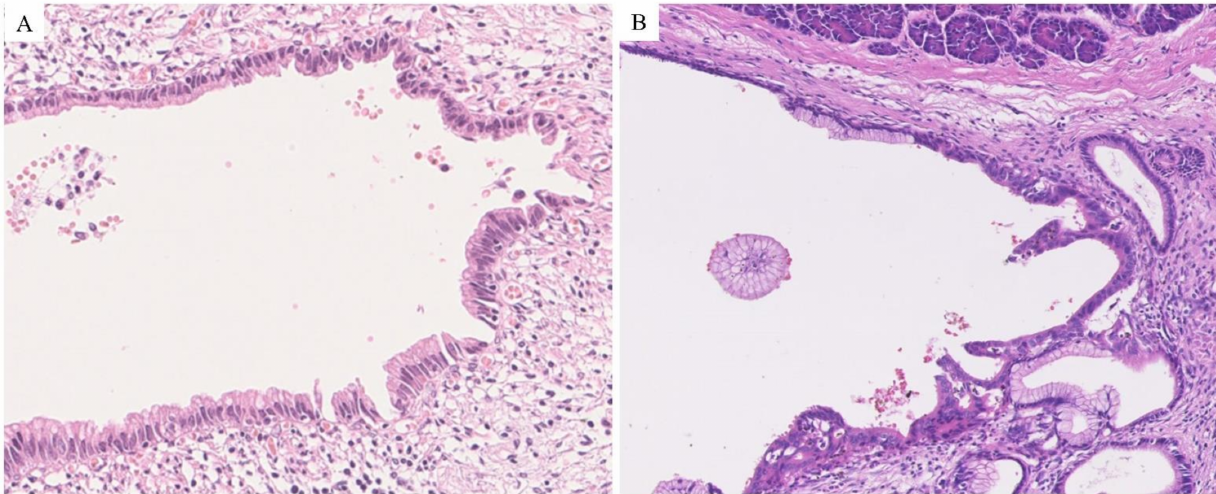
Figure 1. Pathological image of pancreatic intra-epithelial neoplasia (PanIN). ( A ) Low-grade PanIN. Minimal nuclear atypia, absent mitotic figures and flat structure are found. ( B ) High-grade PanIN lesions. Marked atypia consisting of loss of polarity, hyperchromasia, cribriform, micropapillary, and occasional flat architecture are